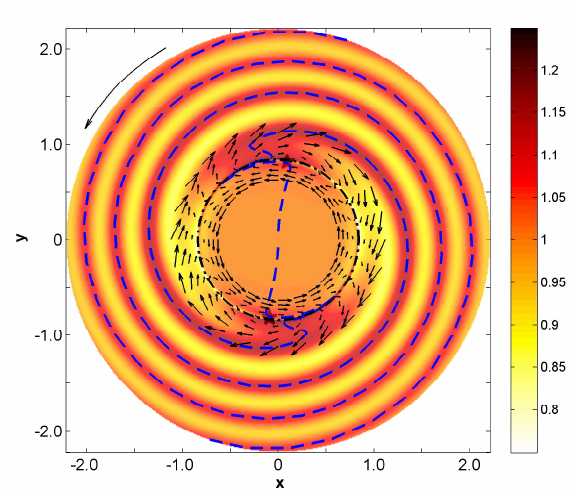
Figure 10. Normalized perturbed surface density σ 1 ( r , φ )/ σ 0 ( r ), for the unstable branch CF , the azimuthal harmonic m = 2, and pa- rameter M * = 15. Case of the model disk having an angular velocity profile (7), (8) with parameters (10), parameter α unperturbed surface density σ 0 ( r ) is described by (13), (14). The scale of the exponential decay of the amplitude with radius, L r > (1.5 − 2) is L e ≈ (3.9 − 4.0)